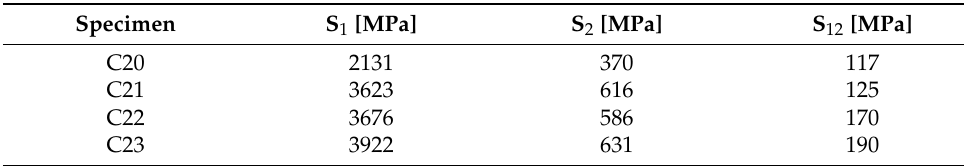
Table 4. Failure